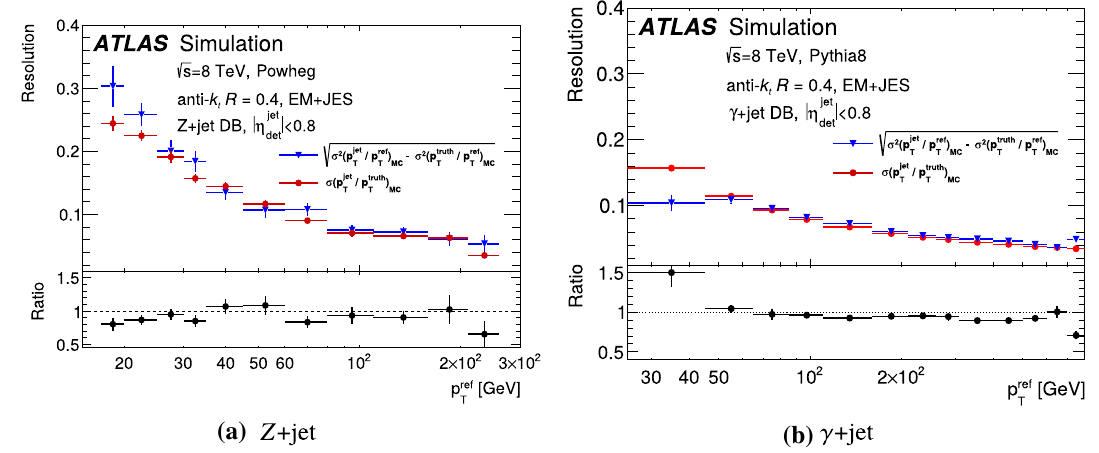
Fig. 35 Comparison of the jet energy resolution determined in situ (triangles) with the MC jet energy resolution (circles) measured for anti- k t EM+JES jets with R = 0 . 4, in a Z +jet and b γ +jet events. The bottom frame shows the ratio of the